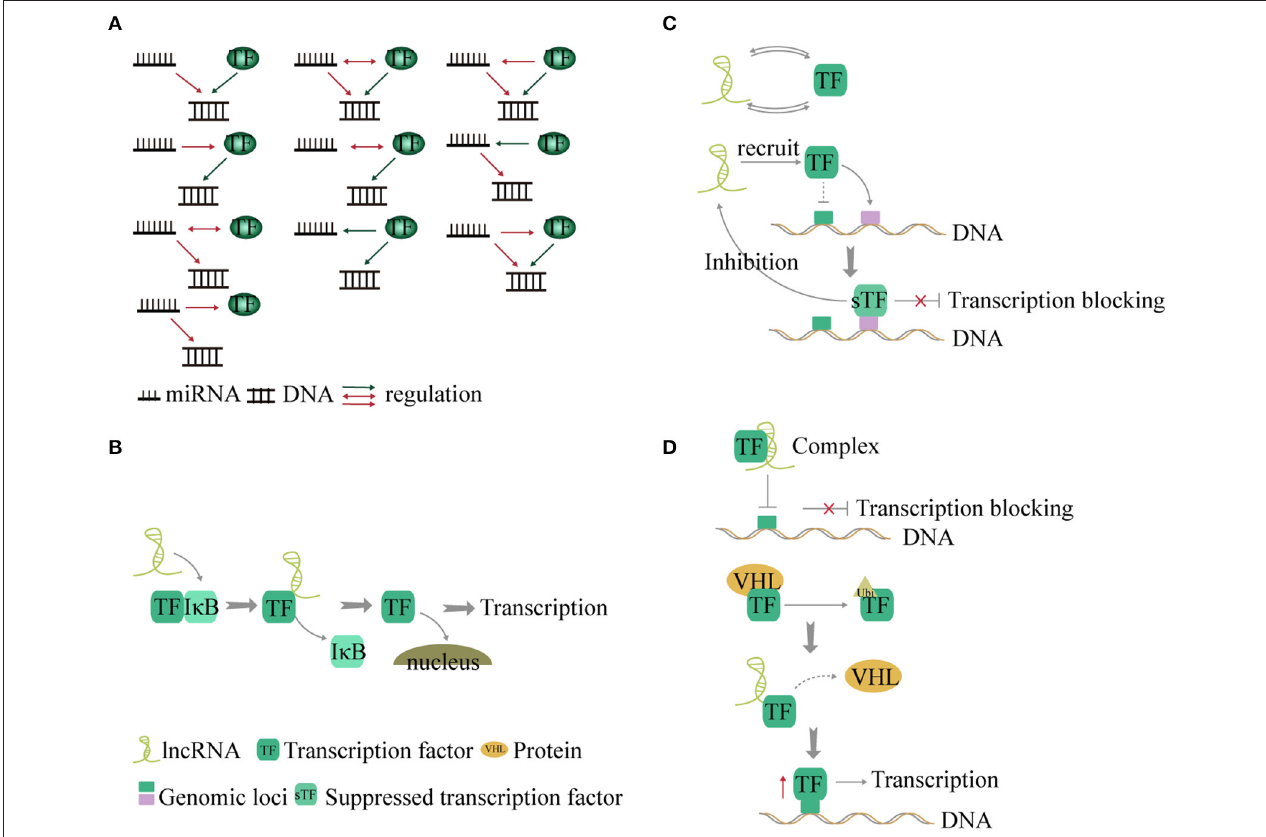
FIGURE 4 | Interaction between non-coding RNA and transcription factors (TFs). (A) TF and miRNA present a feed-forward loop pattern. There are 10 modes of interaction between TF, miRNA, and genes. (B) LncRNAs act as co-factors or inhibitors to control some transcription factor-related signaling pathways. (C) LncRNAs and TFs interact with each other to regulate transcription by forming a binary network. In addition, lncRNA recruits TF to other gene loci and blocks transcription. Conversely the suppressed TF inhibits the expression of the lncRNA. (D) . LncRNA forms a complex with TF to suppress gene transcription. Additionally, lncRNA disrupts the interaction between TF and the VHL protein and forms a complex with TF to reduce the levels of TF ubiquitination, thus increasing the expression of TF and promoting gene